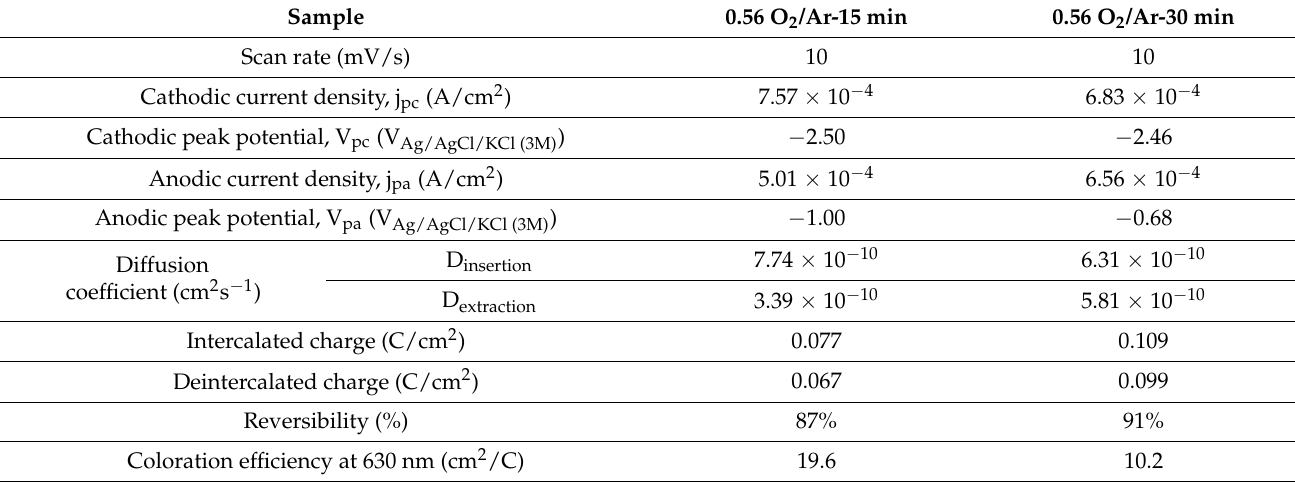
Table 5. Cyclic voltammetry measurements of the 0.56 O 2 /Ar films growth at 15 and 30